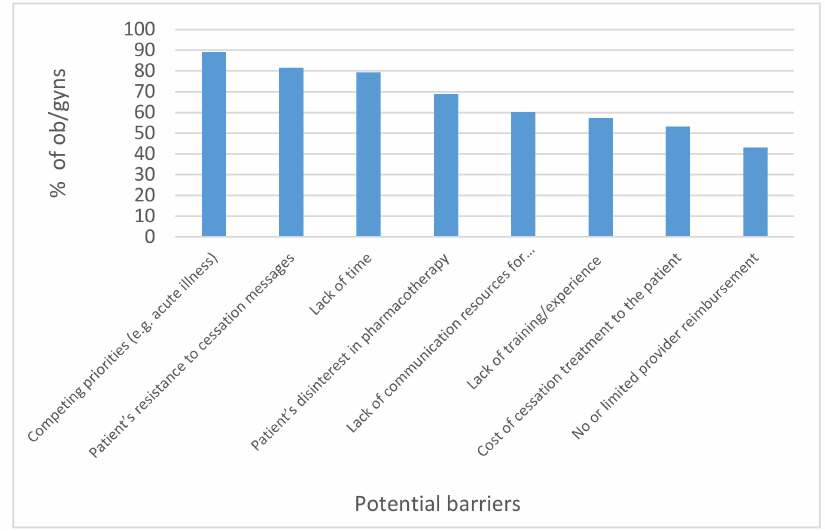
Figure 3. Percentage of ob / gyns that at least somewhat agree with each potential barrier to providing cessation treatment ( n =